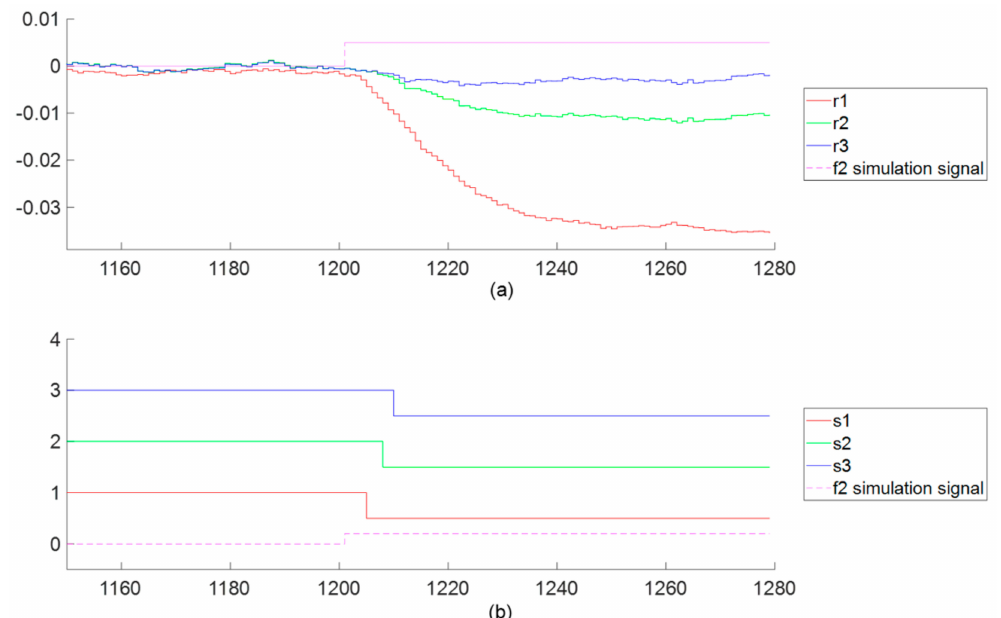
Figure 5. Examples of diagnosing in case of f 2 fault: ( a ) residual values and simulated fault indicator; ( b ) diagnostic signal values (scaled to (cid:104)− 0.5, 0.5 (cid:105) and shifted to s j